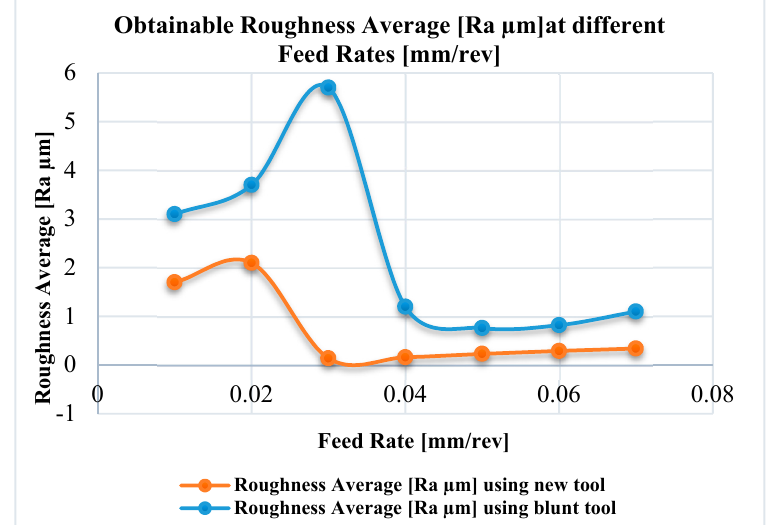
Figure 14. Mean surface roughness as a function of feed rate and tool wear (cutting speed 550 rpm and